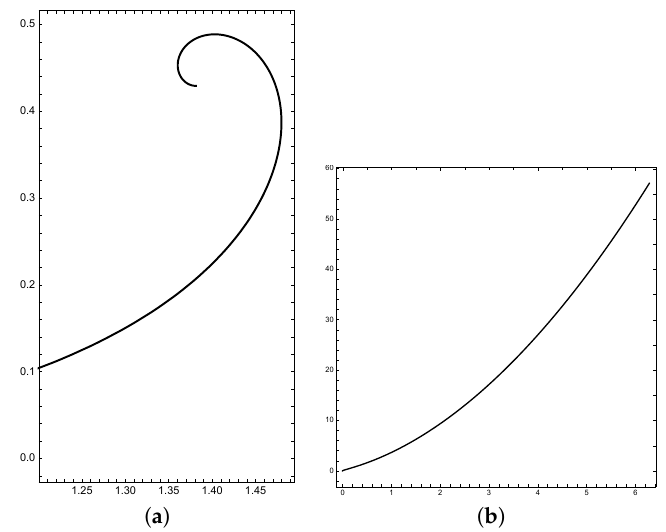
Figure 6. ( a ) Curve with ρ ( θ ) = U ( 2,1.5, θ ) , 0 ≤ θ ≤ 2 π , ( b )